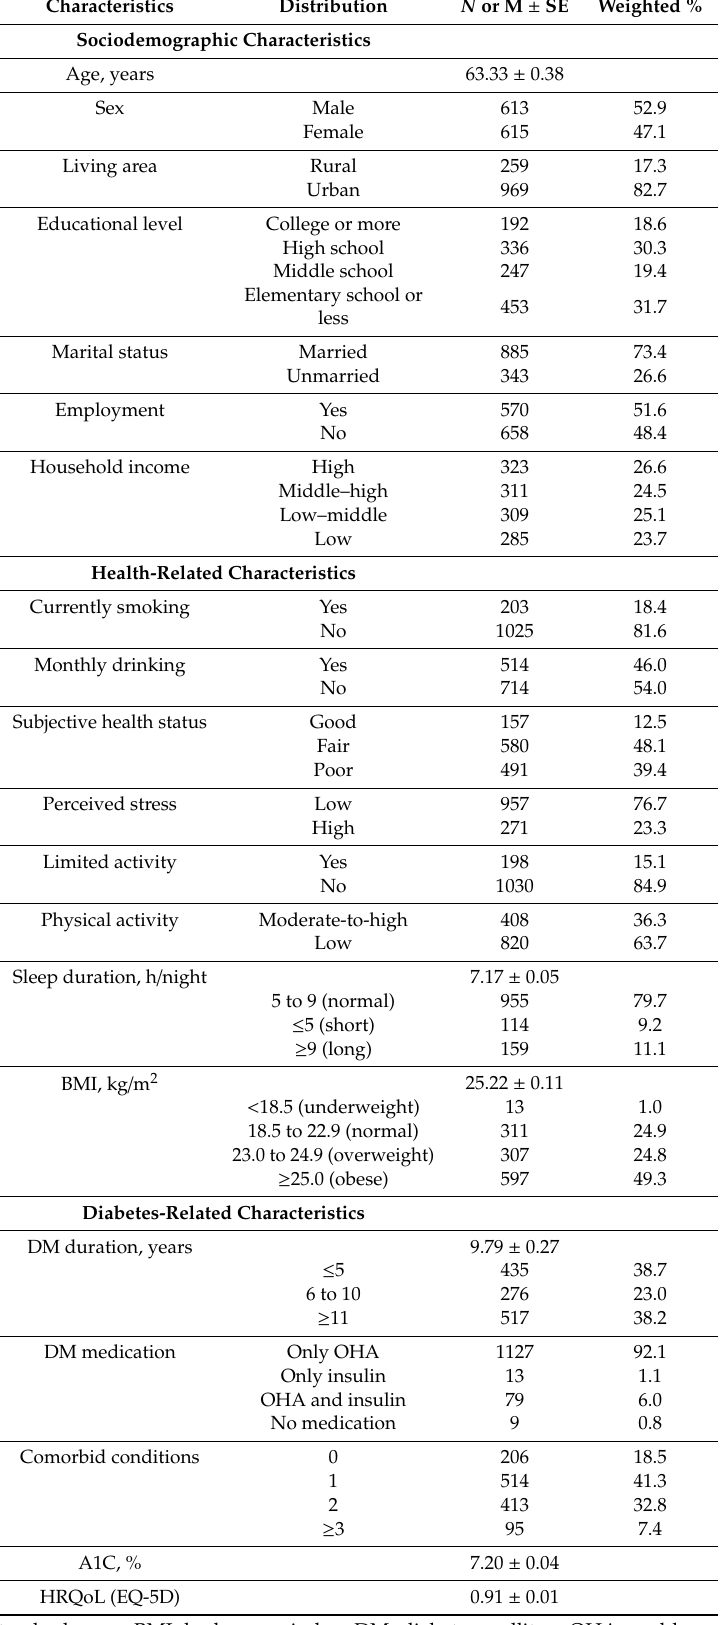
Table 1. Background characteristics of study participants ( n =